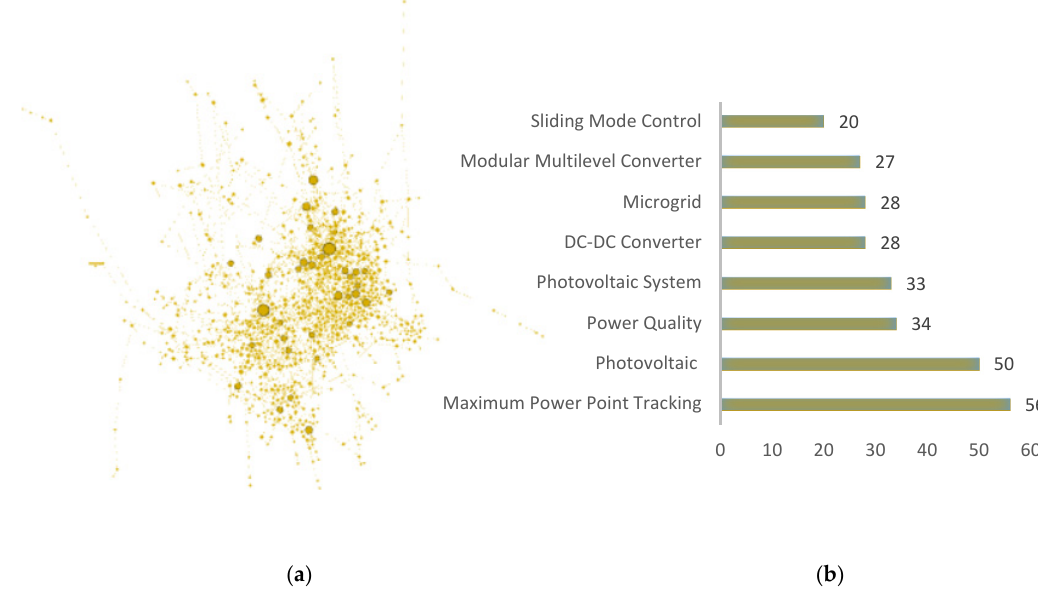
Figure 17. Optimization of the grid link for renewable energy: ( a ) manuscripts published, ( b )